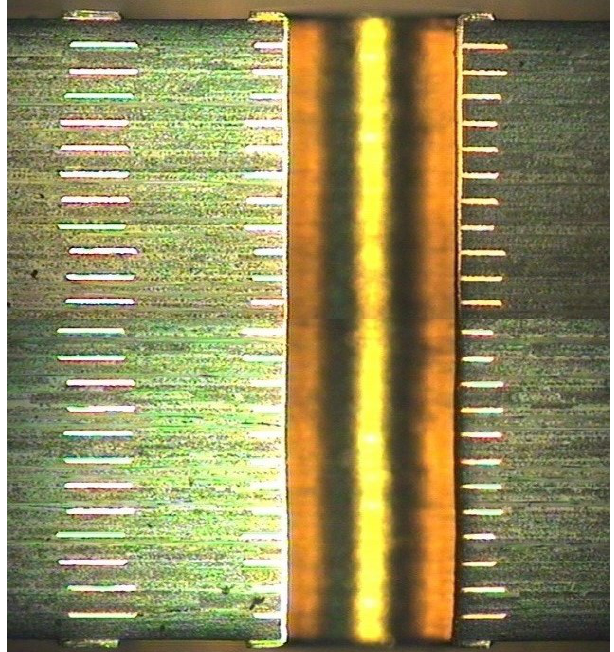
Figure 5. Microscopic view of the PCB stack cross section (witness